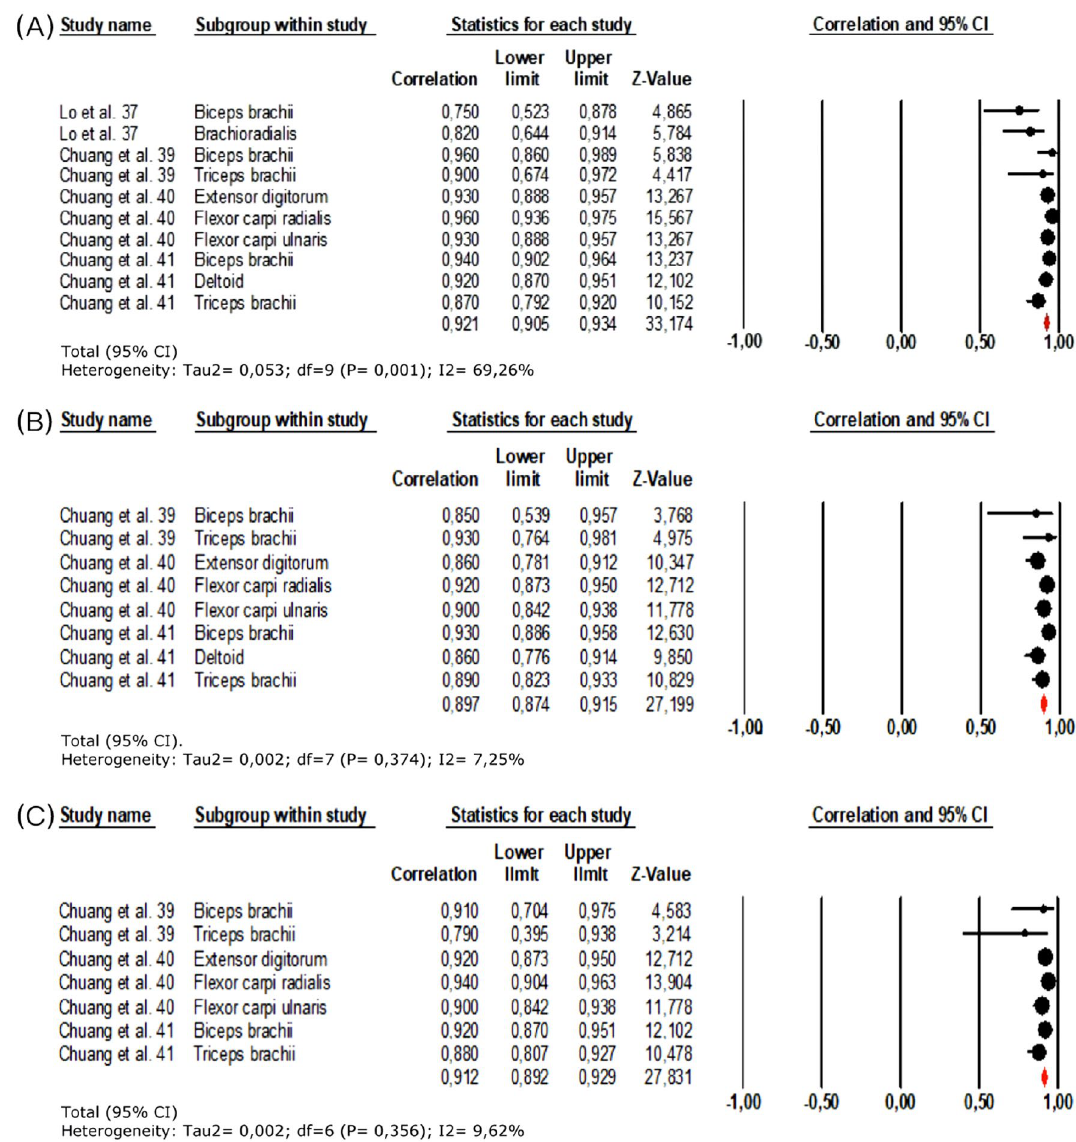
Figure 3. Forest plot of the ICC obtained from intra-rater reliability for upper limbs: ( A ) muscle tone, ( B ) muscle elasticity, ( C ) muscle stiffness.